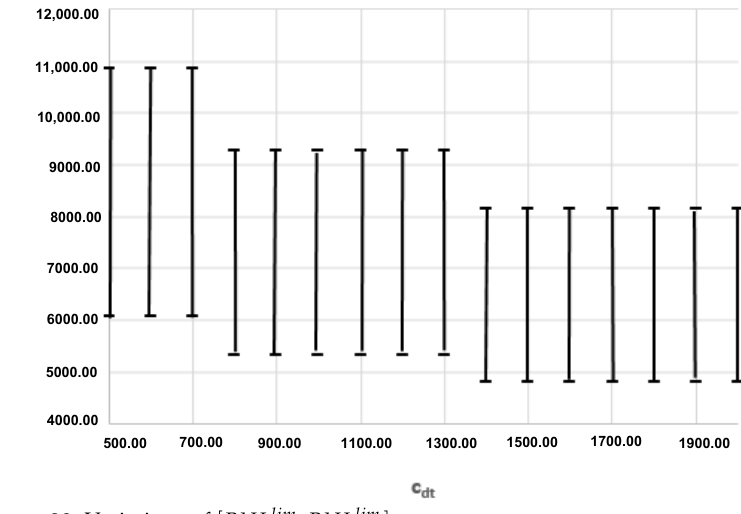
Figure 20. Variations of [ RUL lim